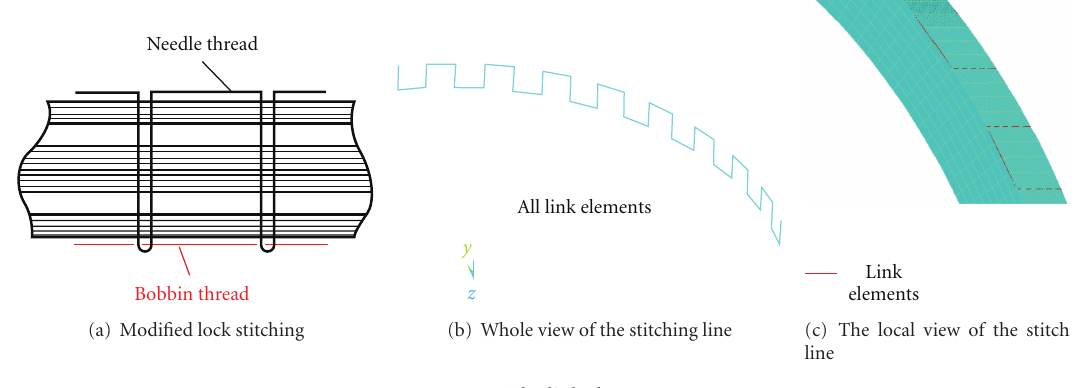
Figure 8: The link elements.